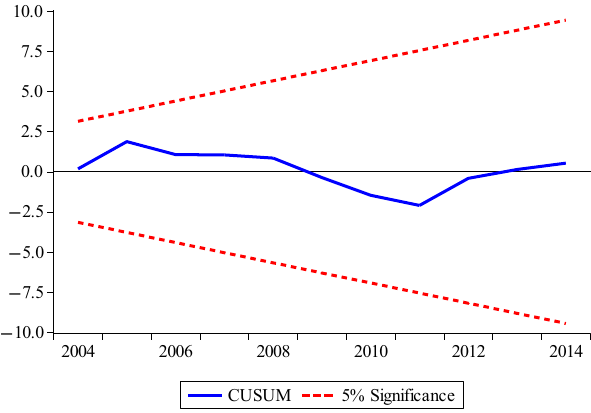
Figure A2. Plot of CUSUM test